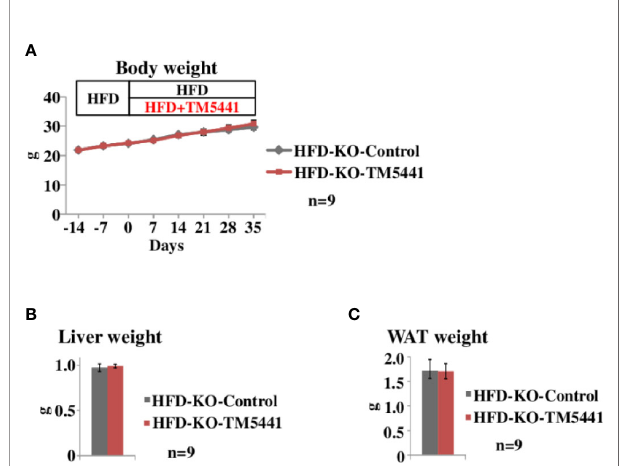
FIGURE 3 | Body weight of lard-rich HFD fed PAI-1 knockout (KO) mice treated with TM5441. (A) Body weight of lard-rich HFD-fed PAI-1 KO mice treated with TM5441. Ten-week-old PAI-1 KO mice that had been pre-fed the lard-rich HFD for 2 weeks were given either lard-rich HFD mixed with TM5441 (HFD-KO-TM5441 mice) or lard-rich HFD (HFD-KO-Control mice) and then were weighed weekly. Each bar represents the mean ± SE of n = 9 mice. (B) Liver weight of HFD-KO-TM5441 and HFD-KO-Control mice. Each bar represents the mean ± SE of n = 9 mice. (C) WAT weight of HFD-KO- TM5441 and HFD-KO-Control mice. Each bar represents the mean ± SE of n = 9